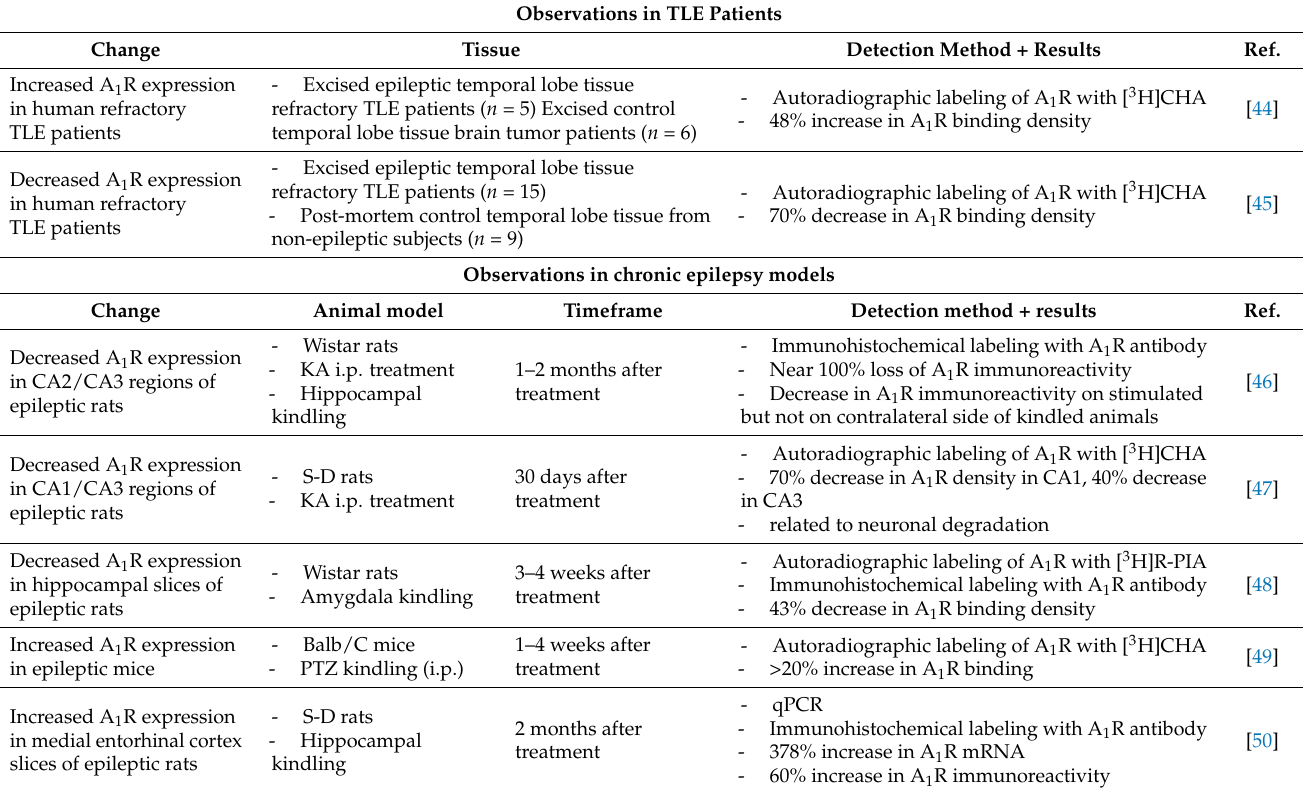
Table 1. Changes in expression levels of A 1 Rs in chronic